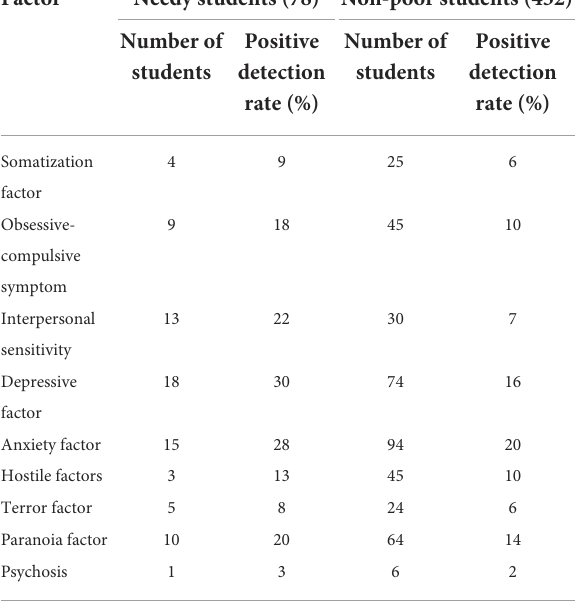
TABLE 4 Distribution of the detection rate of psychological problems.